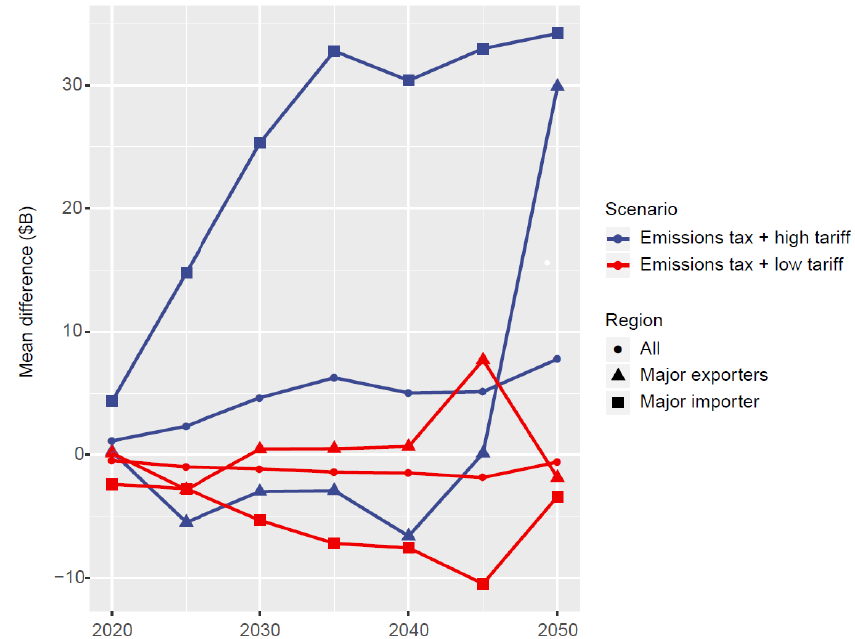
Figure 9. Average regional energy system costs (2020 – 2050). Major exporting regions include Latin America, the Middle East, and Russia. Major importing regions include Pacific Asia, South Asia, and Centrally Planned Asia. All regions include these regions and the remaining 8 regions represented in MESSAGE. Blue lines represent regional costs under an emissions tax and high tariffs, while red lines represent regional costs under an emissions tax and reduced/no tariffs.